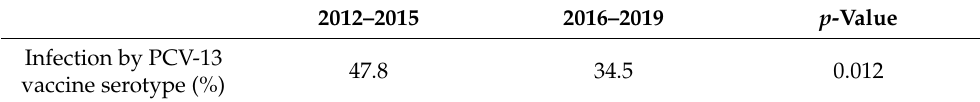
Table 3. Comparative % of IPD from PCV-13 serotypes during the periods of the study.